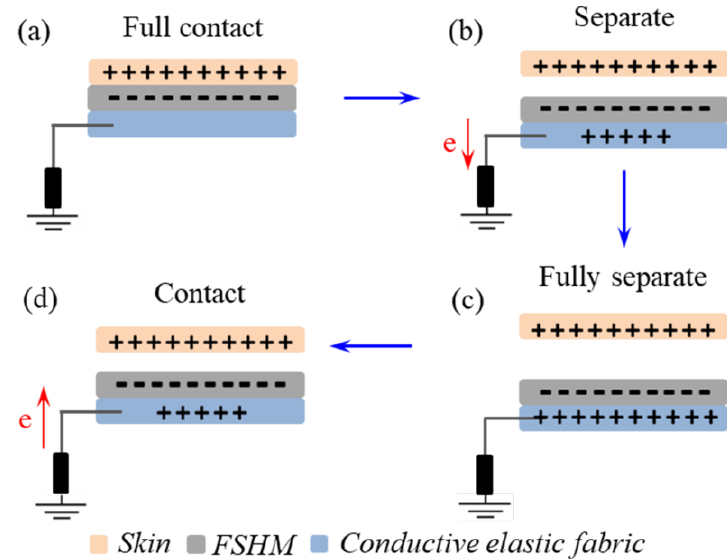
Figure 4. Working mechanism illustration of flexible